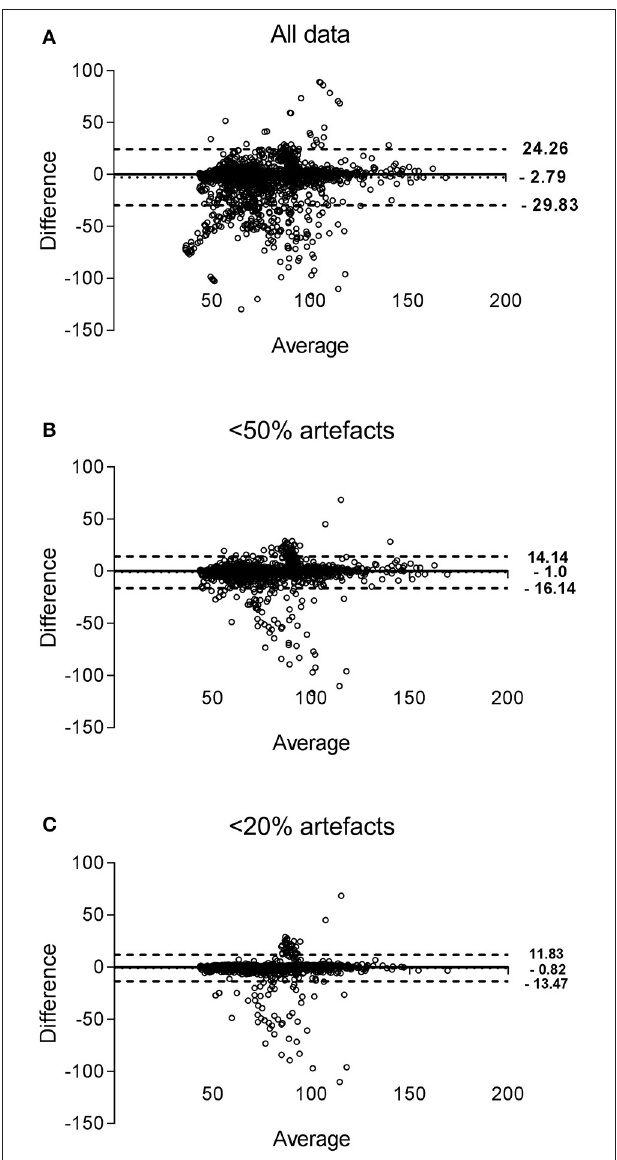
FIGURE 5 | Bland-Altman plots of HR measured by EQ02 and Holter. Each dot represent paired (EQ02-Holter) HR values derived from all participants. The bias of the measurements (represented as solid lines) and the ± 1.96 SD (dotted lines) are presented for the measurements obtained for all data (A) , filtered data containing < 50% (B) artifacts and < 20% artifacts (C) .